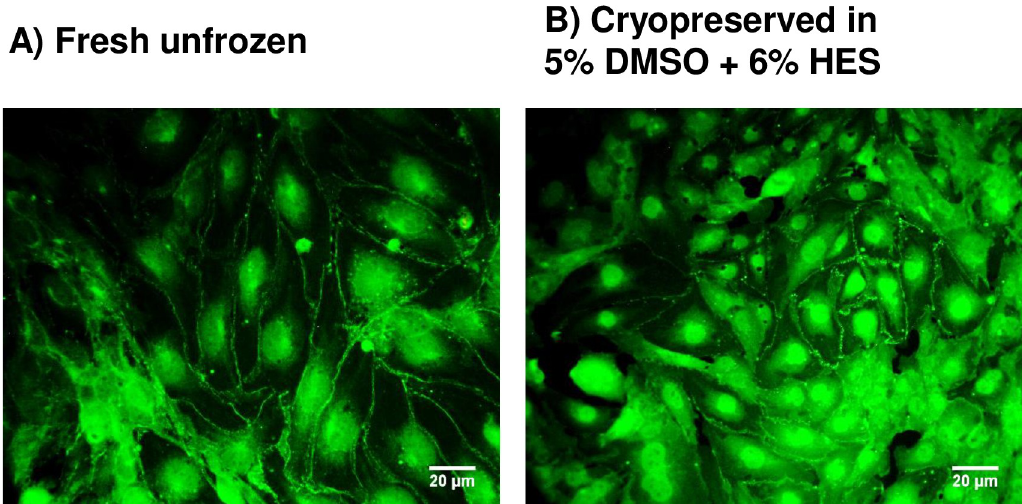
Fig 3. Expression of ZO-1 in hCMEC/D3 cells. (A) Non-cryopreserved (fresh, unfrozen), or (B) cryopreserved in suspension by slow cooling in the presence of 5% DMSO and 6% HES, and then plunging into liquid nitrogen, and then rapidly thawed. Fresh cells and cryopreserved cells in suspension were seeded onto fibronectin-coated glass coverslips and allowed to reach confluency. The cell monolayers stained with ZO-1 antibody conjugated to Alexa Fluor 488 were imaged by fluorescent microscopy.